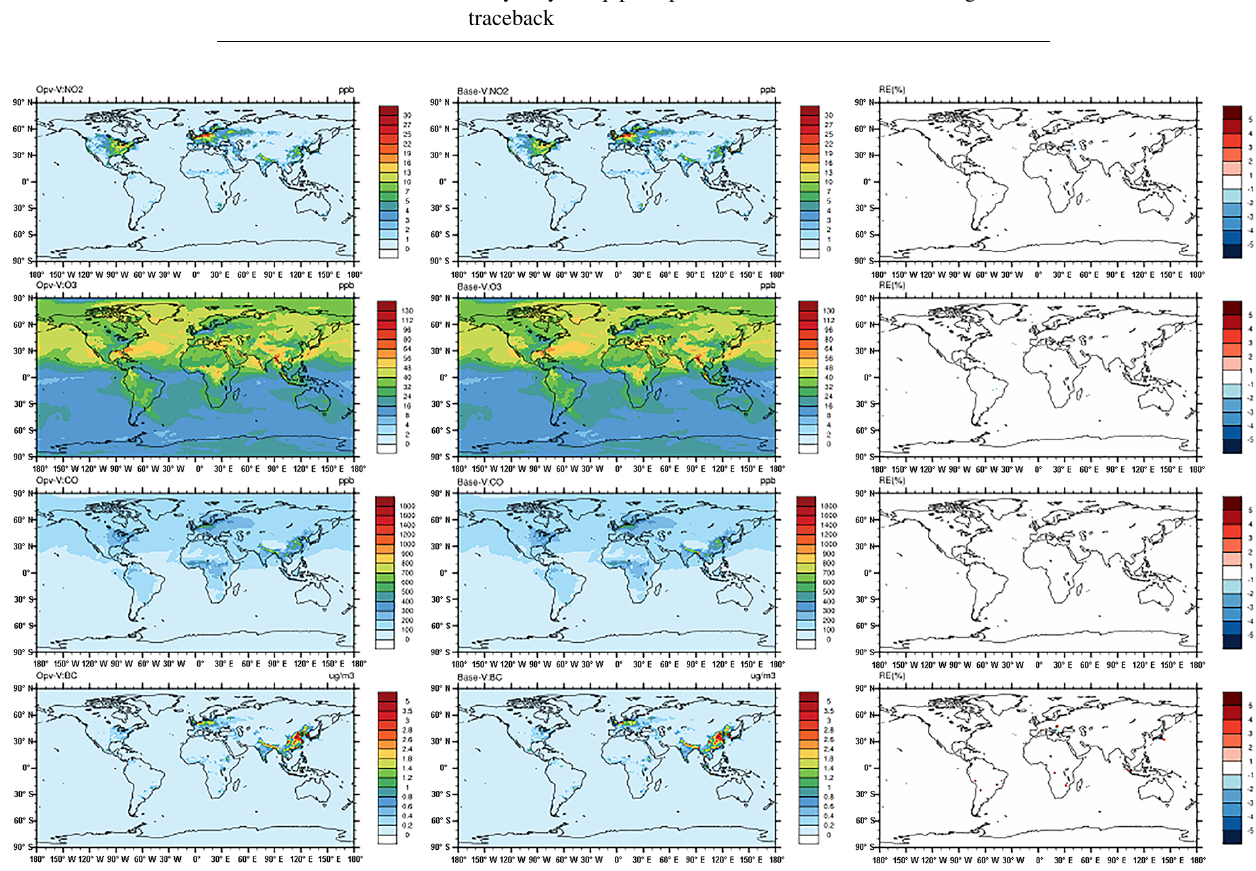
Figure 5. Spatial distribution of BC, CO, O 3 and NO 2 from Opt-V and Base-V